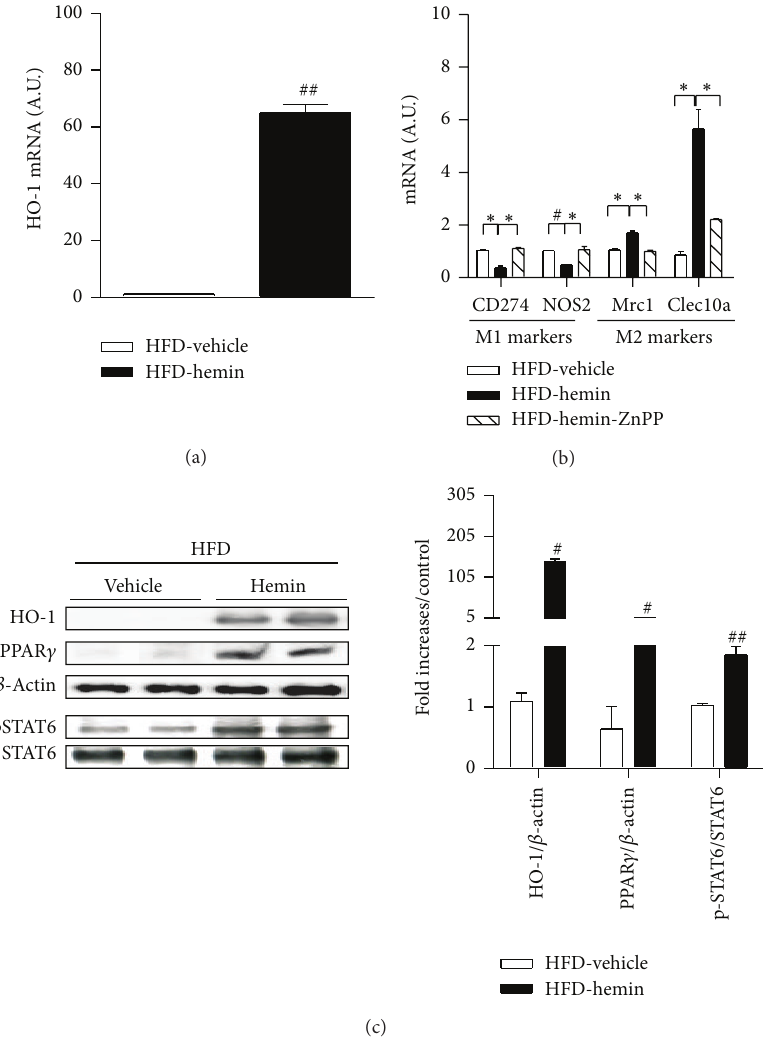
Figure 5: HO-1 induction induces M2 macrophage polarization in adipose tissue. C57BL/6 mice were fed an HFD diet for 2 weeks with hemin alone or hemin in combination with ZnPP injection for 3 times per week ( 𝑛 = 5 ). (a) The level of HO-1 transcripts in adipose tissue was detected by qRT-PCR. (b) Total RNAs were isolated and the levels of M1 marker (CD274, NOS2) and M2 markers (Mrc1, Clec10a) were analyzed by qRT-PCR; 𝛽 -actin was used as control gene. A.U.: arbitrary units. (c) Levels of HO-1, PPAR 𝛾 , and pSTAT6/STAT6 were detected by western blotting. Results are means ± SEM. ∗ 𝑃 < 0.05 , # 𝑃 < 0.005 , and ## 𝑃 < 0.001 (compared with HFD-vehicle